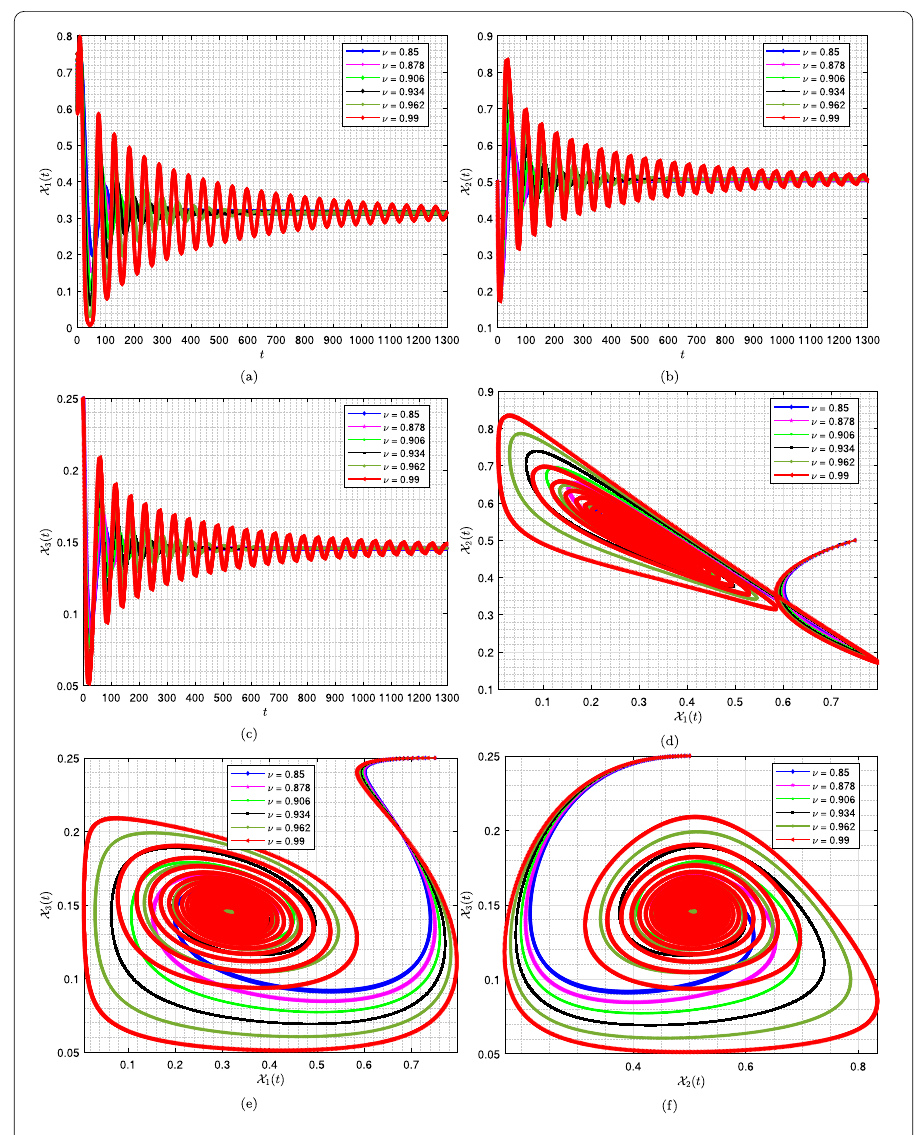
Figure 7 Dynamics for system (19) for different parameters in Set4